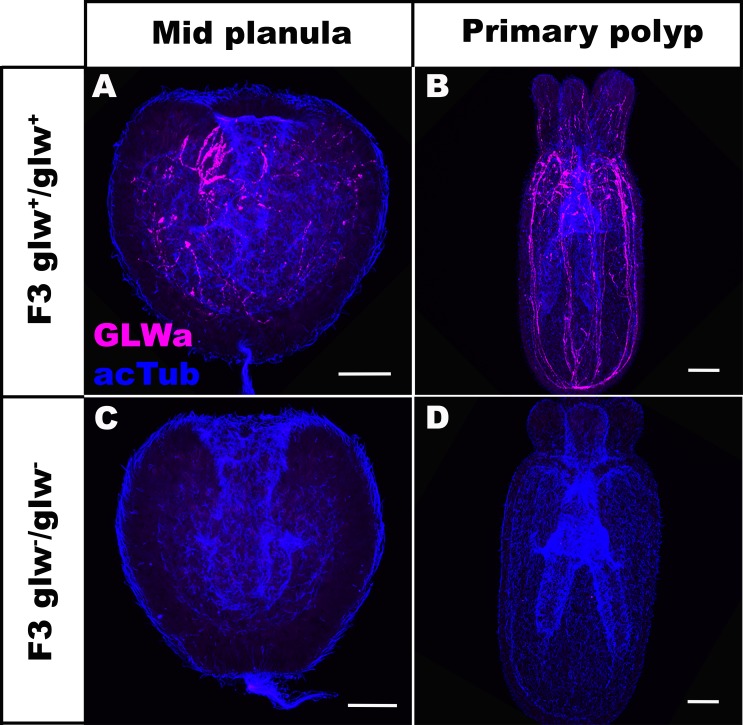
F3 GLWamide null mutant planulae transform into polyps.Confocal sections of F3 wild-type (A, B) and mutant (glw-/glw-, C, D) Nematostella vectensis, labeled with antibodies against GLWamide (‘GLWa’) and acetylated ∂-tubulin (‘acTub’). All panels show side views of animals with the blastpore/mouth facing up. (A, C) Mid-planula. (B, D) Primary polyp. All panels show Z-projections of sections through the entire animals. F3 null mutants were generated by crossing F2 glw-a/glw-c adults with each other, and F3 wildtype animals were generated by crossing F2 glw+/glw+ adults with each other; glw-a/glw-c and glw+/glw+ F2 adults were siblings. Possible genotypes of F3 glw-/glw- null mutants were therefore glw-a/glw-a, glw-a/glw-c, or glw-c/glw-c. Note the lack of GLWamide immunostaining in glw-/glw- null mutants, which provides experimental evidence that there are no other GLWamide-like peptides present at the developmental stages investigated. Thus NvLWamide-like does not generate GLWamides, as predicted from the amino acid sequence data (see main text). Scale bar: 50 µm.